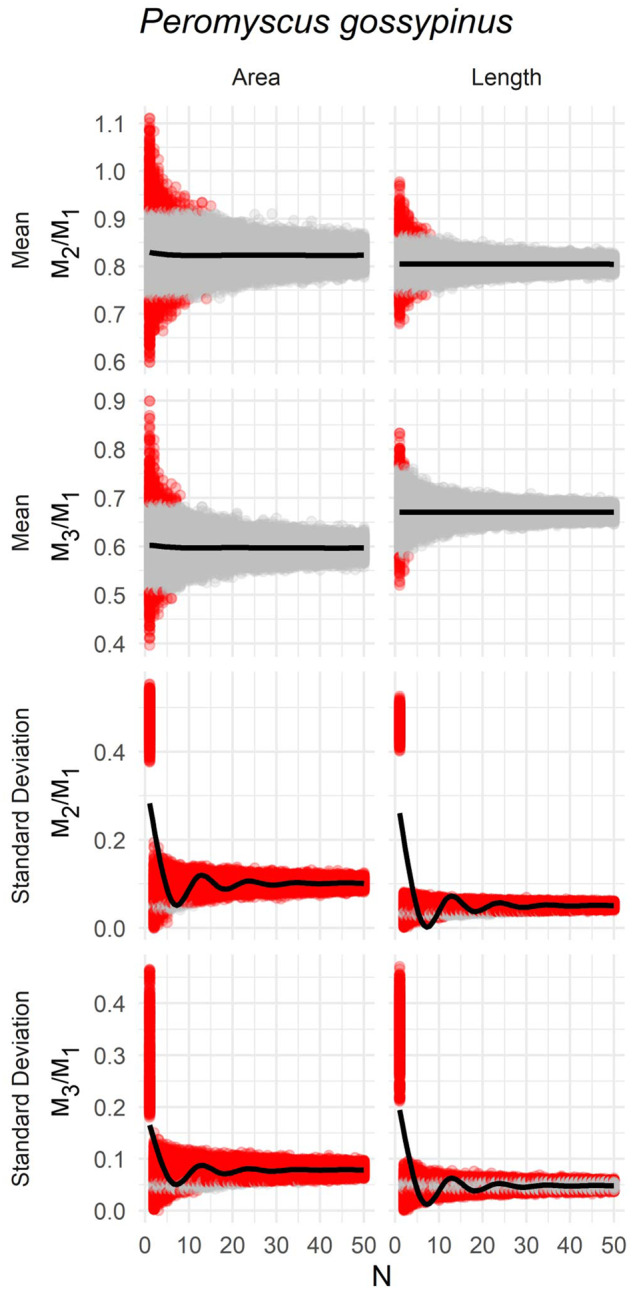
Relationship between sample size and estimates of mean and SD of ratios calculated to study ICM (area) or MMC (length) based on resampling individual molars from molar rows of P. gossypinus to make composite molar rows. Each gray point is one of 10,000 pseudoreplicates sampled at N sample size. Black line indicates the mean value calculated from pseudoreplicates. Red points indicate pseudoreplicate samples whose mean or SD is outside the 95% CI around the observed value calculated for the complete N = 70 sample.